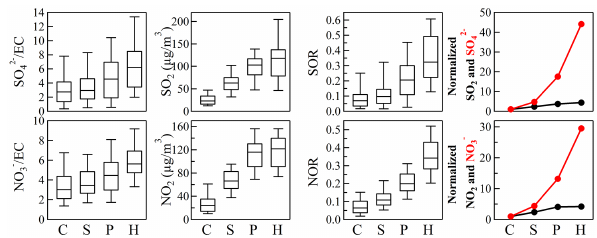
/EC, NO − /EC, SO 2 , NO 2 , SOR and Figure 10. Variation of SO 2 − 4 3 NOR with pollution level. “C”, “S”, “P”, “H” refer to “clean”, “slightly polluted”, “polluted” and “heavily polluted”, respectively. Normalized X in Column 4 refers to the average concentration of X in any pollution level, scaled by its average concentration dur- ing clean periods. In the box-whisker plots, the boxes and whiskers indicated the 95th, 75th, 50th (median), 25th and 5th percentiles,